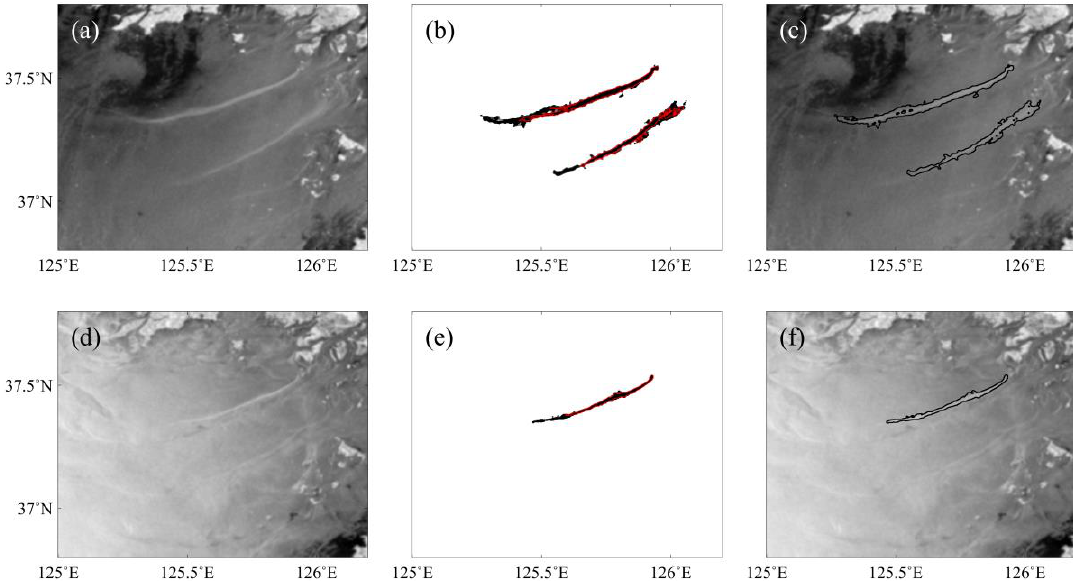
Figure 6. Examples of detected tidal channel features. Distributions of sigma nought after incidence angle normalization ( a ) on 11 December and ( d ) 27 August 2007, respectively. ( b , e ) are the detected features after incidence angle normalization, where the red edge lines indicate detected features from those without incidence angle normalization, and ( c , f ) are the edge boundaries which were extracted by Canny edge detection overlaid on the SAR sub-scenes.